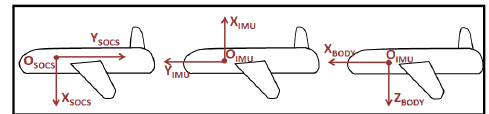
Figure 4. Orientation of platform based coordinate systems (left